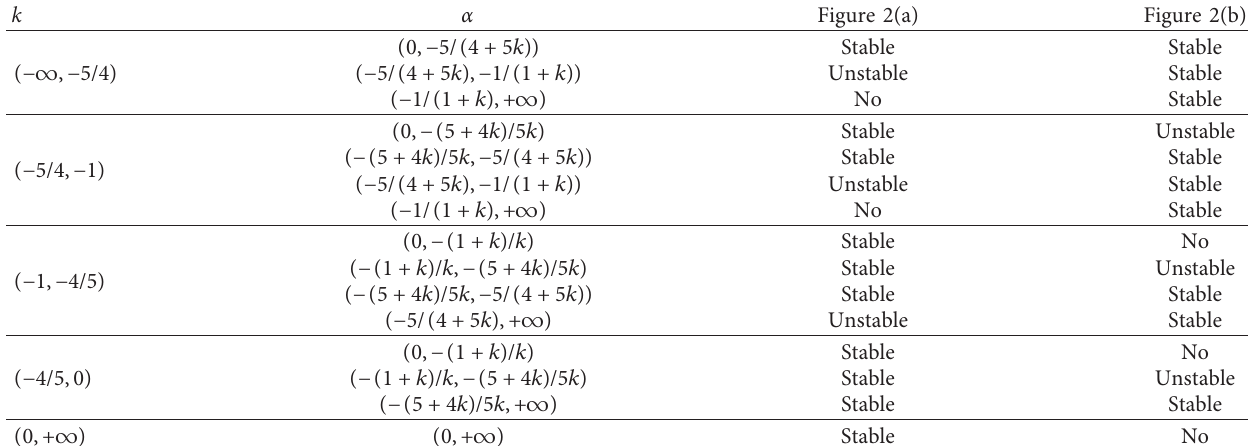
Table 2: Stability criterion for scenario 2( k is fixed and α is the control parameter). k Figure 2(a) Figure